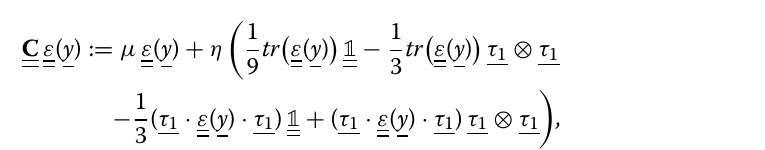
with μ = 80 kPa, η = 3400 kPa. In what follows, we present the results for a transversely isotropic medium in which the fibre direction τ 1 varies linearly along the direction y